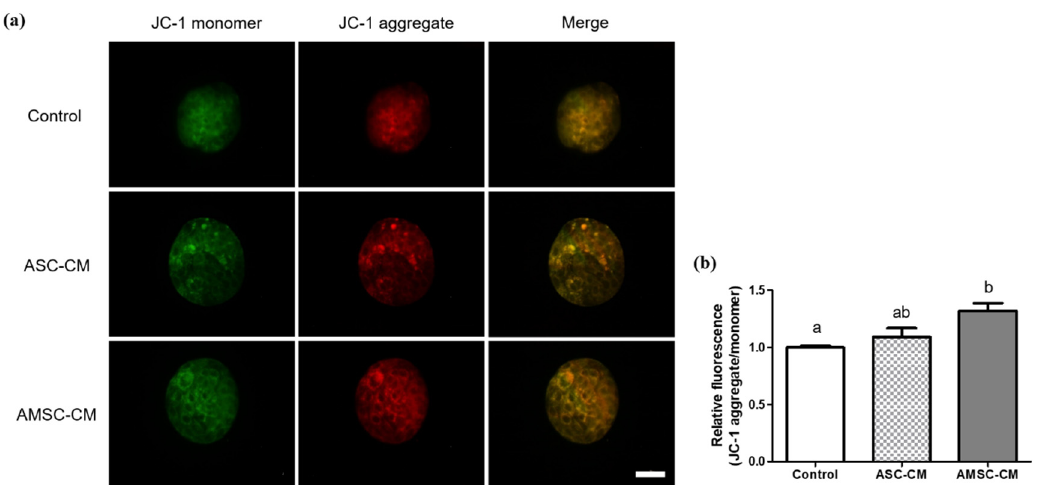
Figure 8. Assessment of mitochondrial membrane potential in blastocysts (BL) cultured with human adipose-derived mesenchymal stem cell conditioned medium (ASC-CM) and amniotic membrane-derived mesenchymal stem cell condi- tioned medium (AMSC-CM). ( a ) Representative fluorescent images of JC-1 monomer (green) and aggregate (red) stained BL. Original magnification 400 × . Scale bar = 50 µ m. ( b ) The ratio of JC-1 aggregate (red) to JC-1 monomer (green) pre- sented by quantifying fluorescence intensity of JC-1 mitochondrial membrane potentials in BL. Data are expressed as the mean ± standard error of the mean (SEM). Superscript letters in each column indicate significant differences ( p <